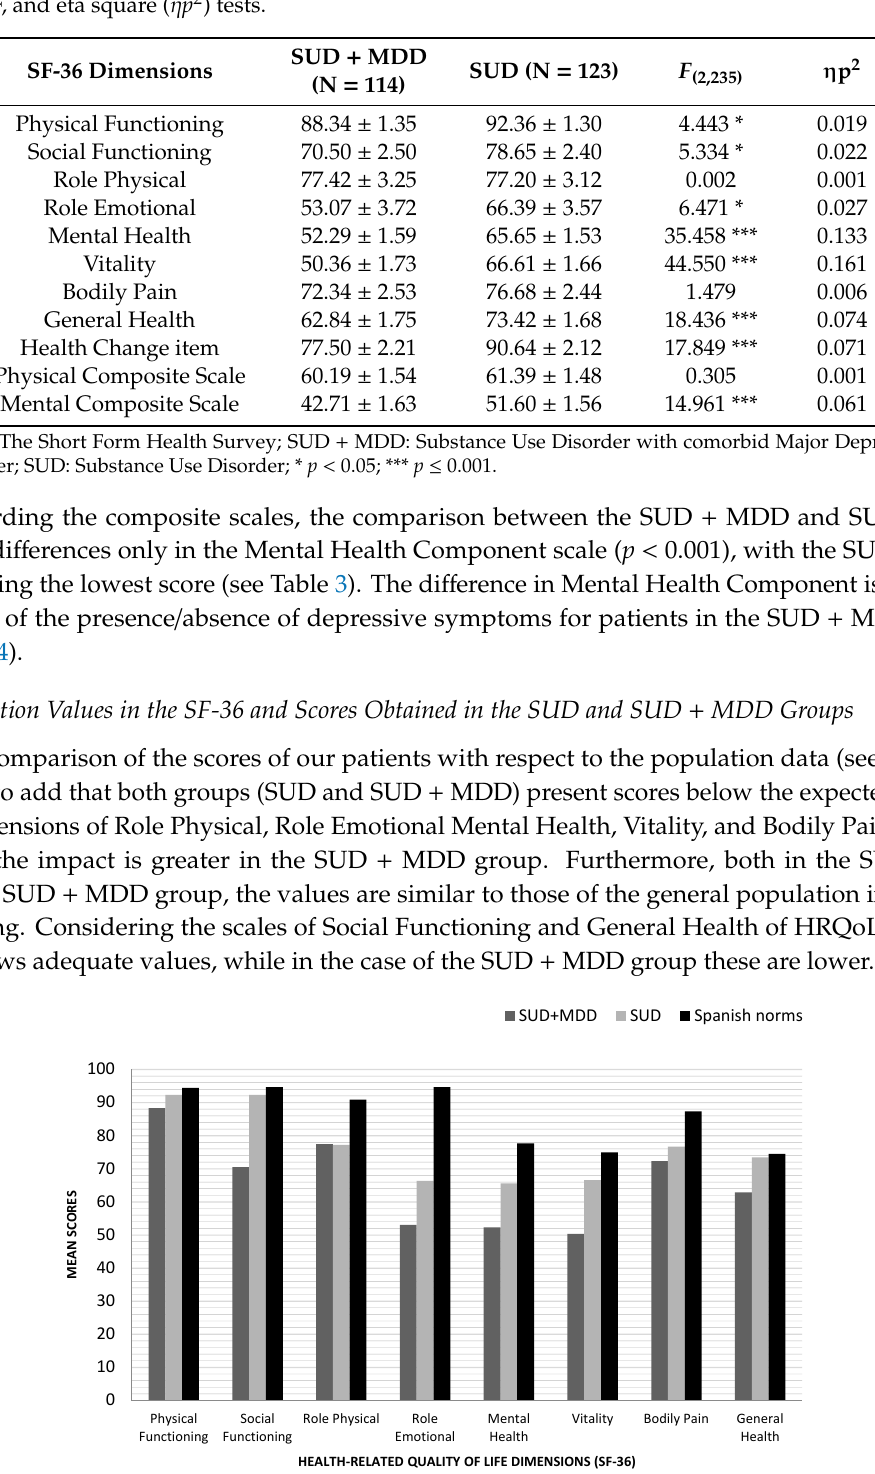
Figure 1. Mean scores in health-related quality of life dimensions (SF-36) according to the diagnosis, comparison with Spanish normative data from healthy individuals. SF-36: The Short Form Health Survey; SUD + MDD: Substance Use Disorder with comorbid Major Depression Disorder; SUD: Substance Use Disorder.